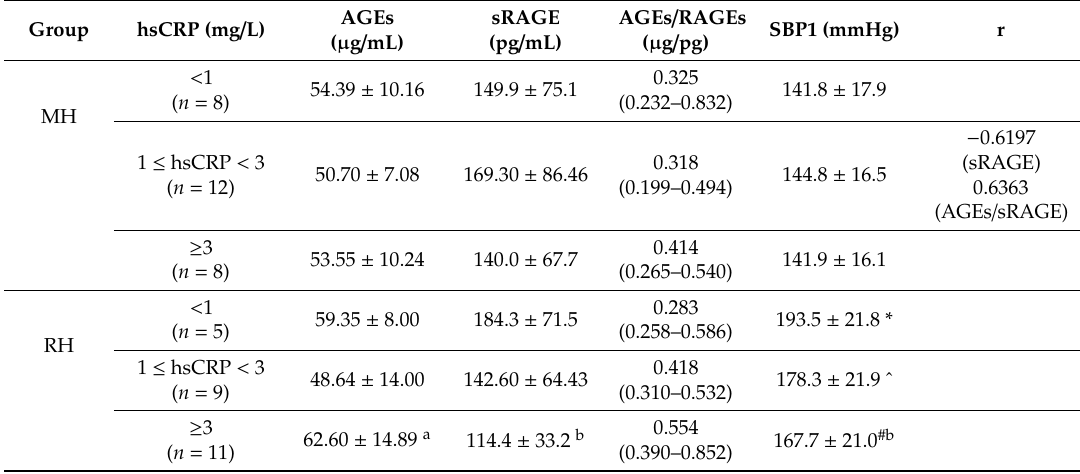
Table 3. The influence of hsCRP concentration on AGEs, RAGEs, AGEs / RAGEs ratio, and SBP1 in MH and RH